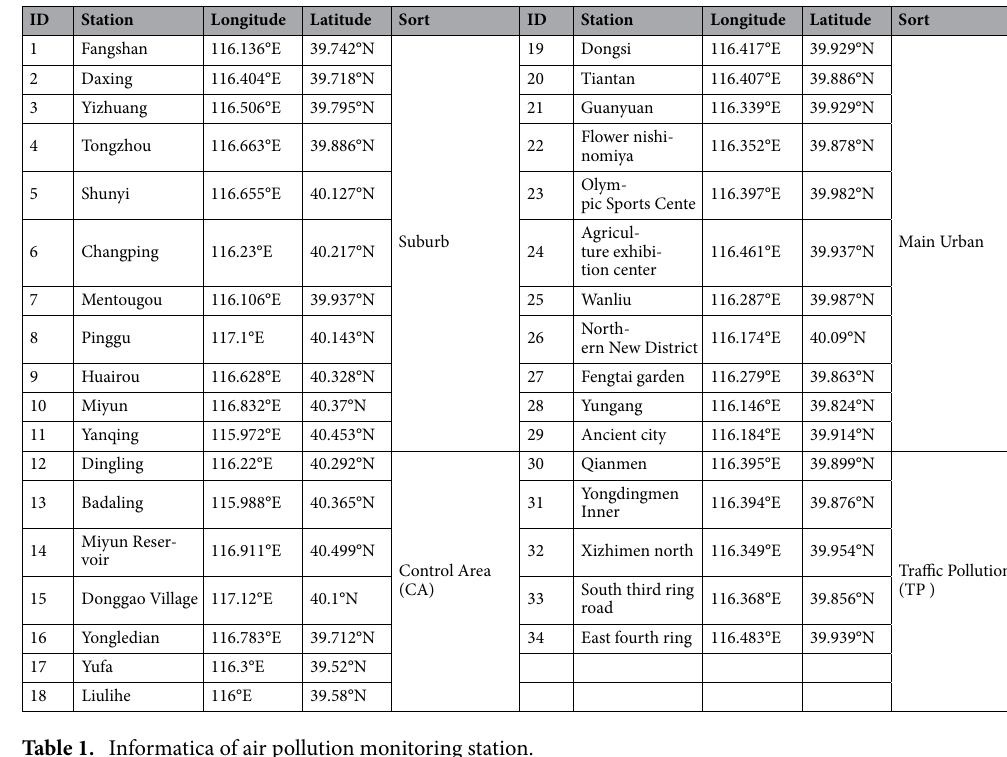
Table 1. Informatica of air pollution monitoring station.